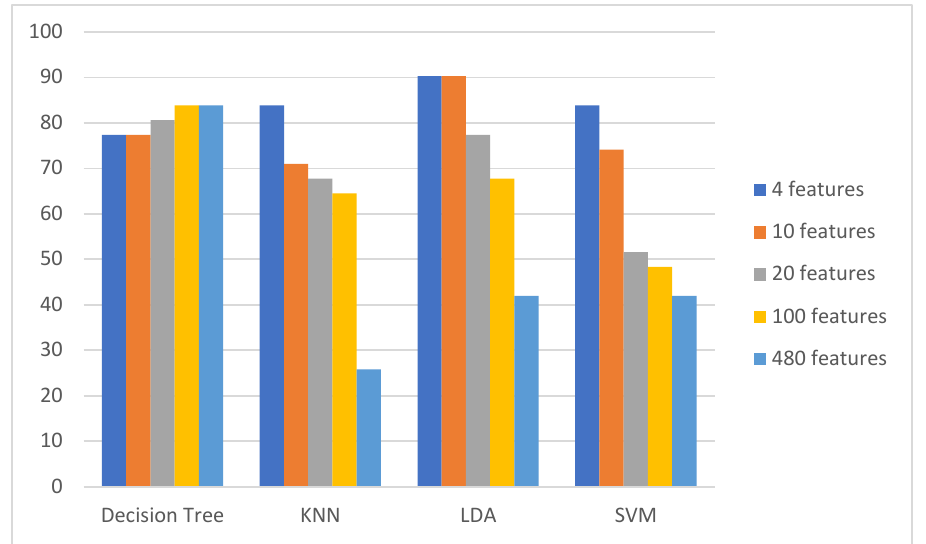
Figure 6. Visualizing the performance of ROC feature selection in our thermal "mock crime" dataset by three classification models. The vertical axis is the accuracy percentage result and the horizontal axis is the classifier model. The colors show the results with reduced number of features.